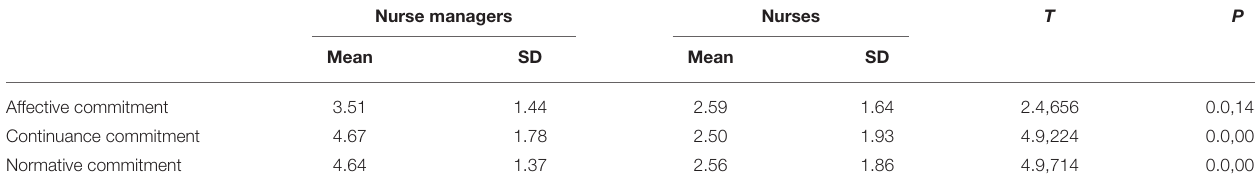
TABLE 3 | Nurse managers’ and staff nurses’ perceptions of organizational loyalty.